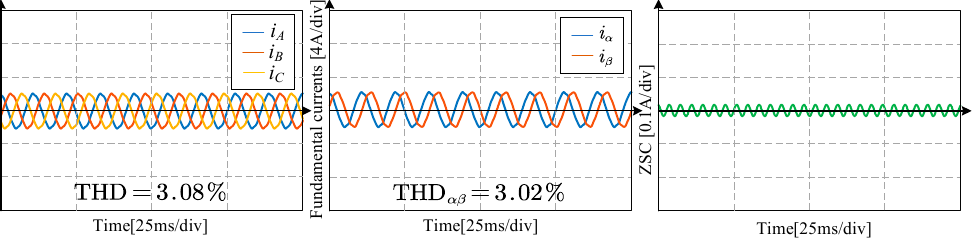
Figure 14. Simulation steady-performance of the conventional controller under 1200 rpm reference.